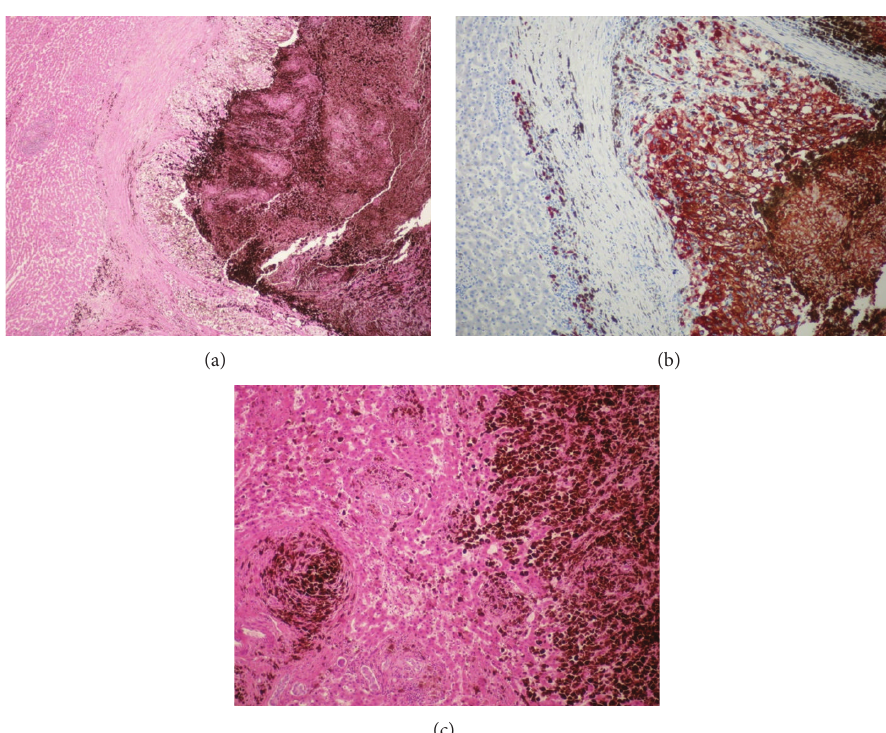
Figure 2: (a) Malignant melanoma, containing melanin pigment in the cytoplasms. Large, pleomorphic, vesicular nuclei and large clear cytoplasm with HMB45 positive reaction. Liver parenchyma in the surrounding, 4 × 10MR. (b) Malignant melanoma infiltration containing melanin pigment in the cytoplasms. Large, pleomorphic, vesicular nuclei and large clear cytoplasm with atypic cells. Liver parenchyma in the surrounding. H × E, 4 × 10MR. (c) Malignant melanoma, containing melanin pigment in the cytoplasms, recessive cellular details, infiltrating to the surrounding liver parenchyma. H × E, 10 ×